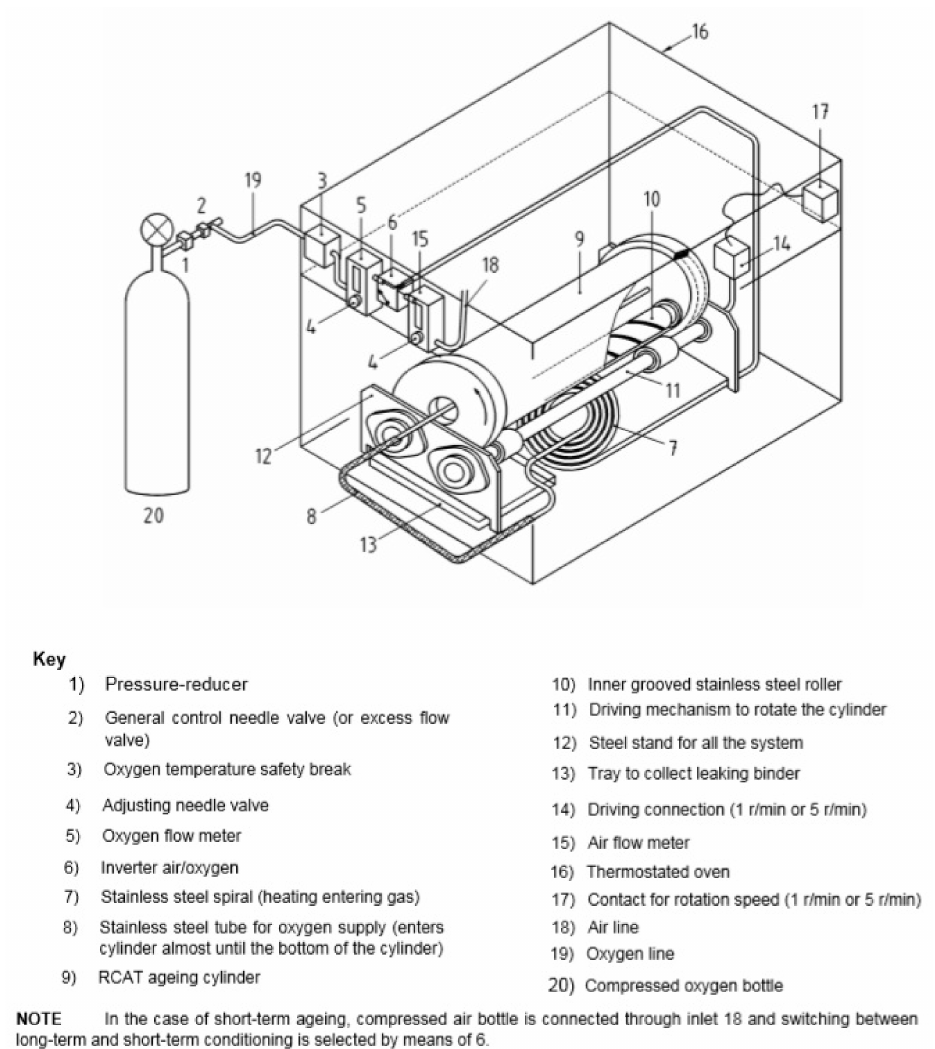
Figure 8. Schematic diagram of the RCAT aging apparatus (EN